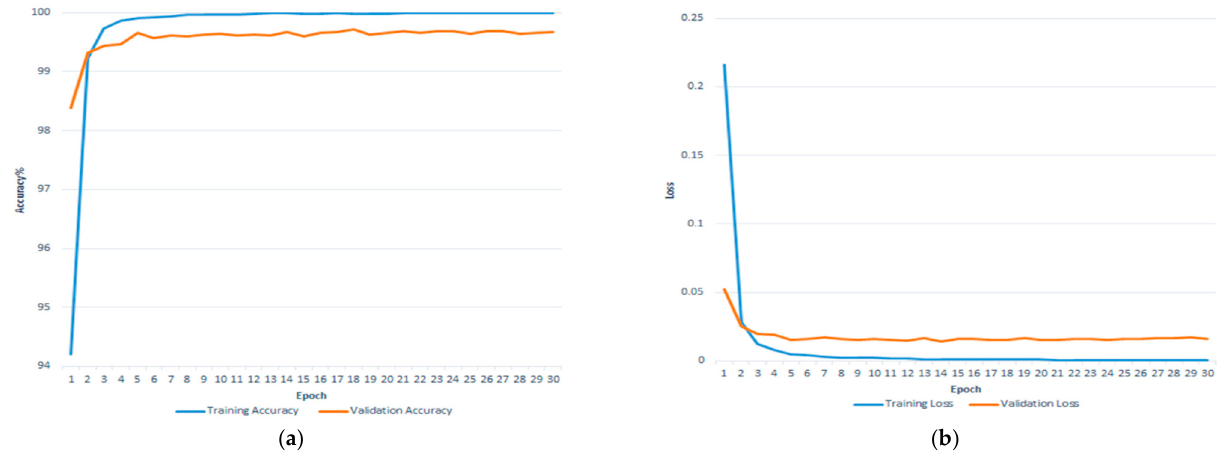
Figure 7. Recognition accuracy of ResNet-50. ( a ) Training and testing accuracy; ( b ) training and validation loss in ResNet-50 using PlantVillage dataset.